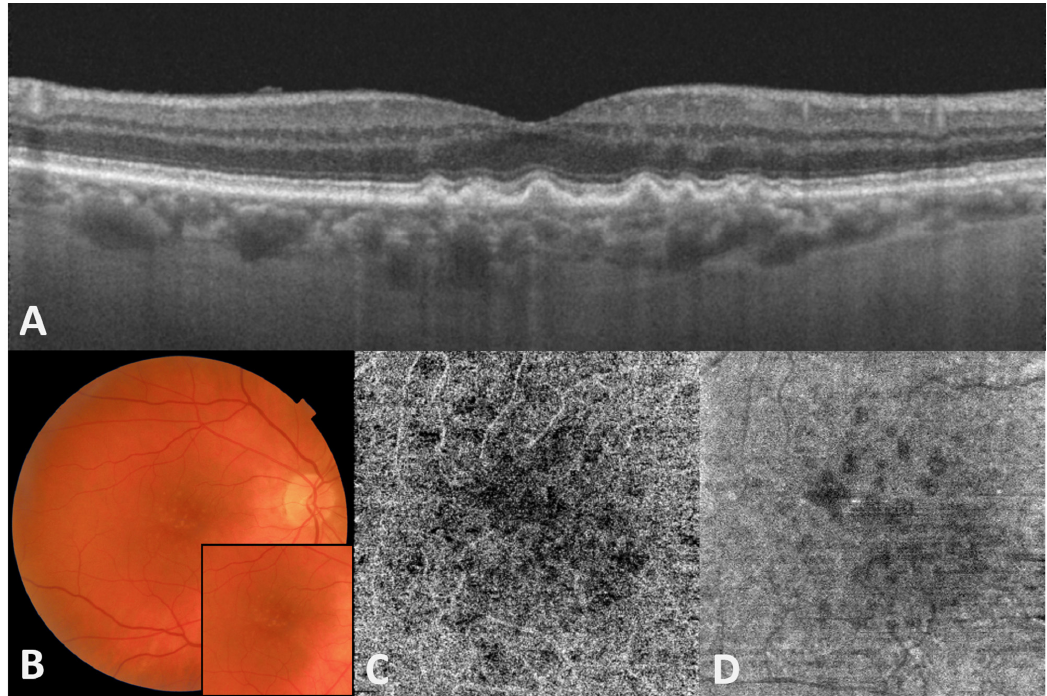
Figure 1. Right eye of an 86-year-old male patient with macular drusen. ( A ) Optical coherence tomography (OCT) B-scan centered on the fovea showing multiple drusen and no signs of exudation. ( B ) Color fundus photography of the posterior pole showing partially confluent small and intermediate drusen in the macular region. No hemorrhages or other signs of exudation are present. ( C ) OCT-angiography 4.5 × 4.5 mm macular slab segmented at the choriocapillaris level showing multiple areas of low signal due to reduced perfusion but no signs of macular neovascularization. ( D ) Corresponding en-face structural choriocapillaris image showing defects underlying drusen.